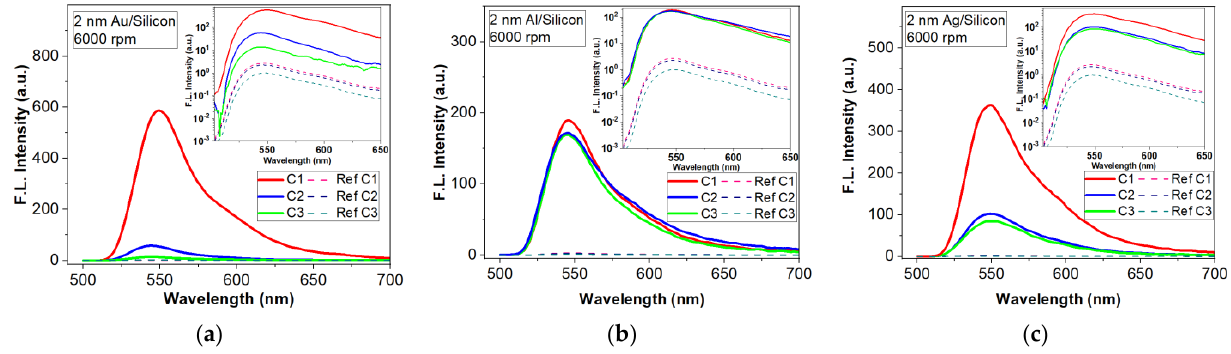
Figure 5. Florescence intensity enhancement by a 2 nm metallic (mass equivalent) films on silicon substrate (inset are the FLEN with logarithmic y scale): ( a ) Au meta-atoms; ( b ) Al meta-atoms; ( c ) Ag meta-atoms.